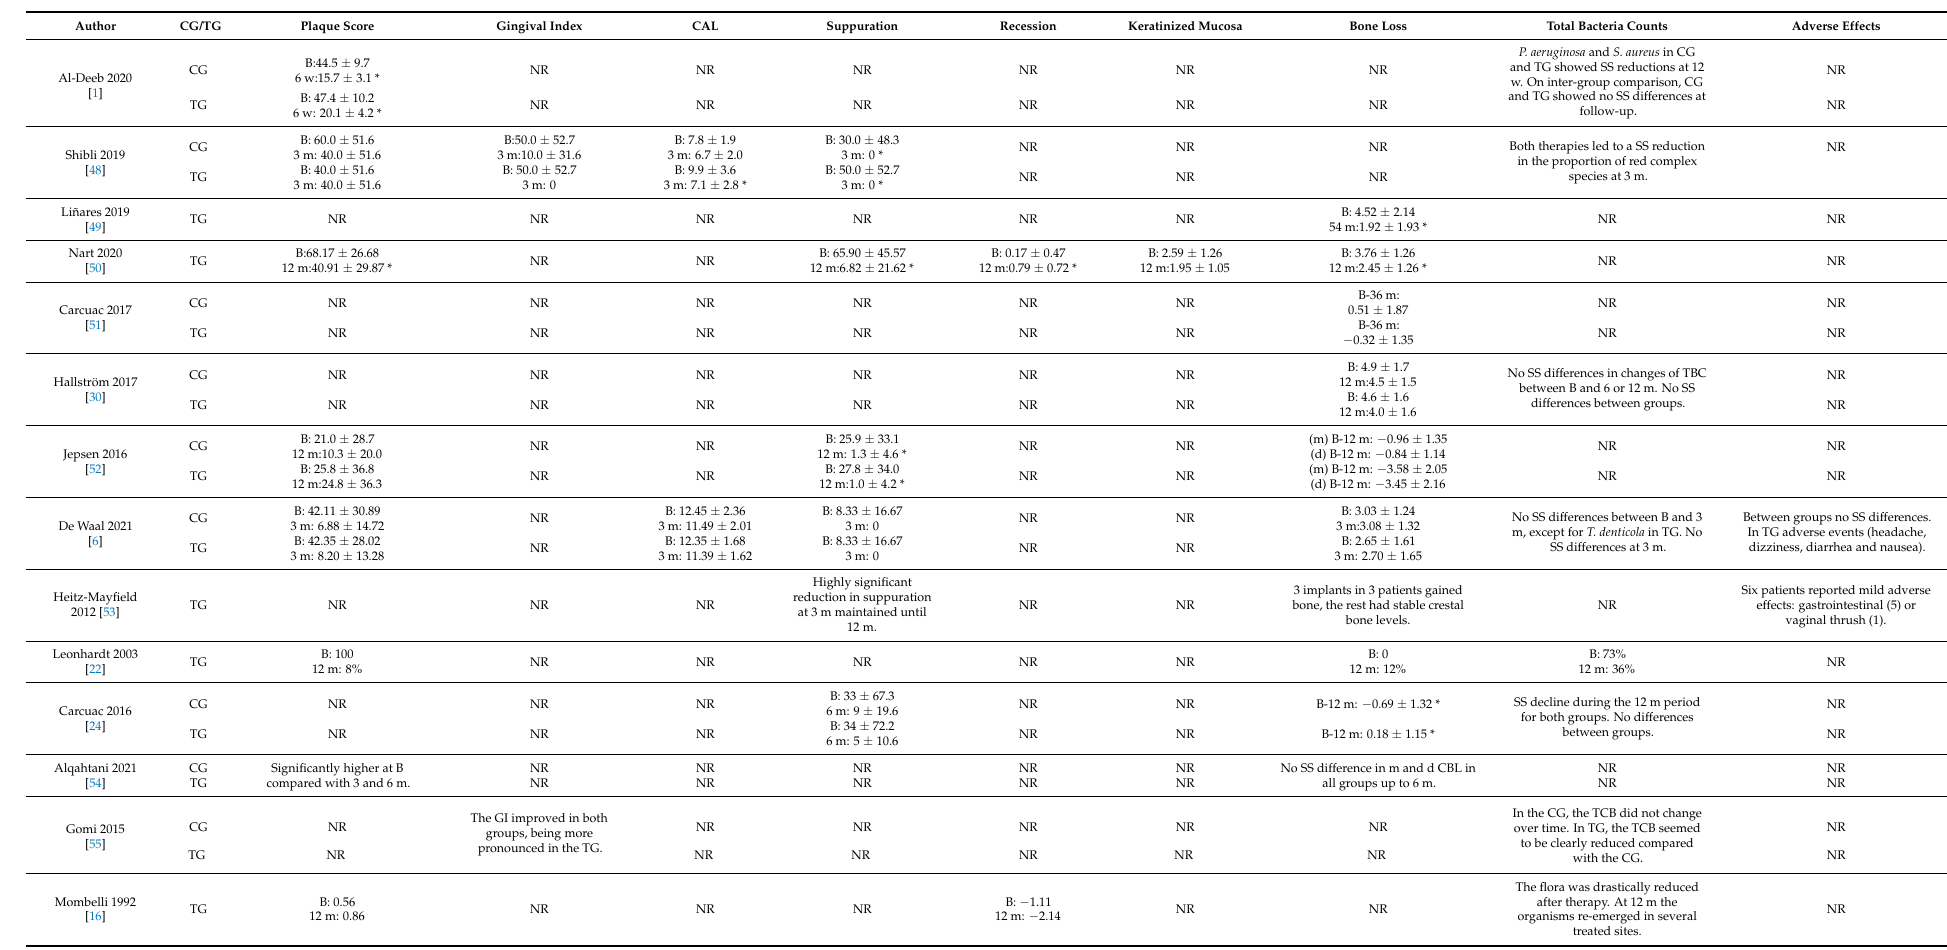
Table 3. Summary of secondary outcomes.